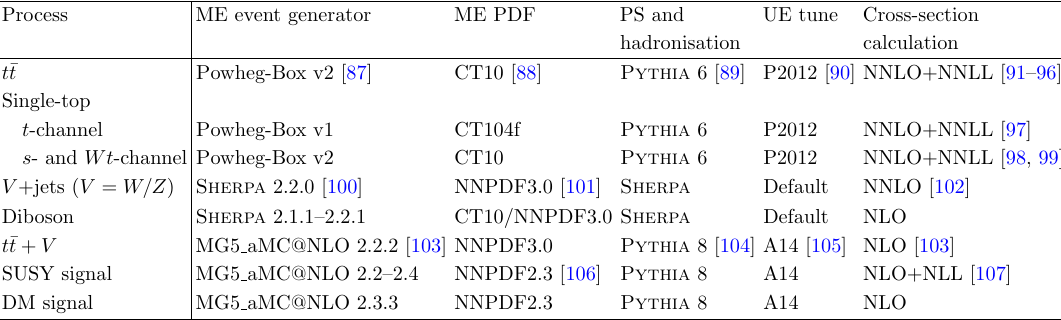
Table 1 . Overview of the nominal simulated